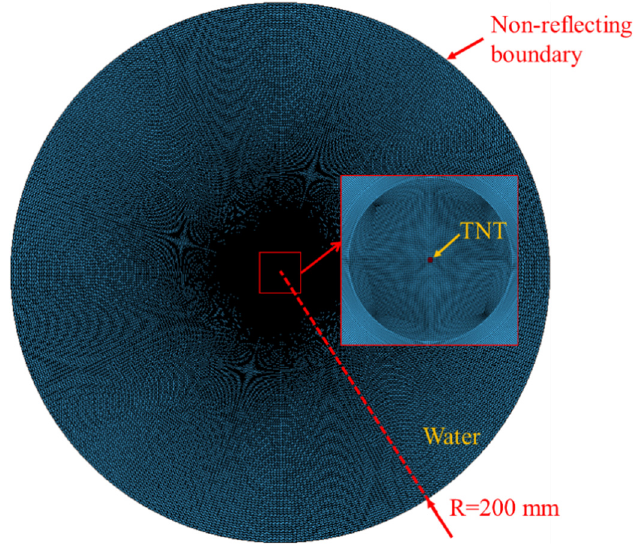
Figure 4. Computational model of a free-field underwater explosion.